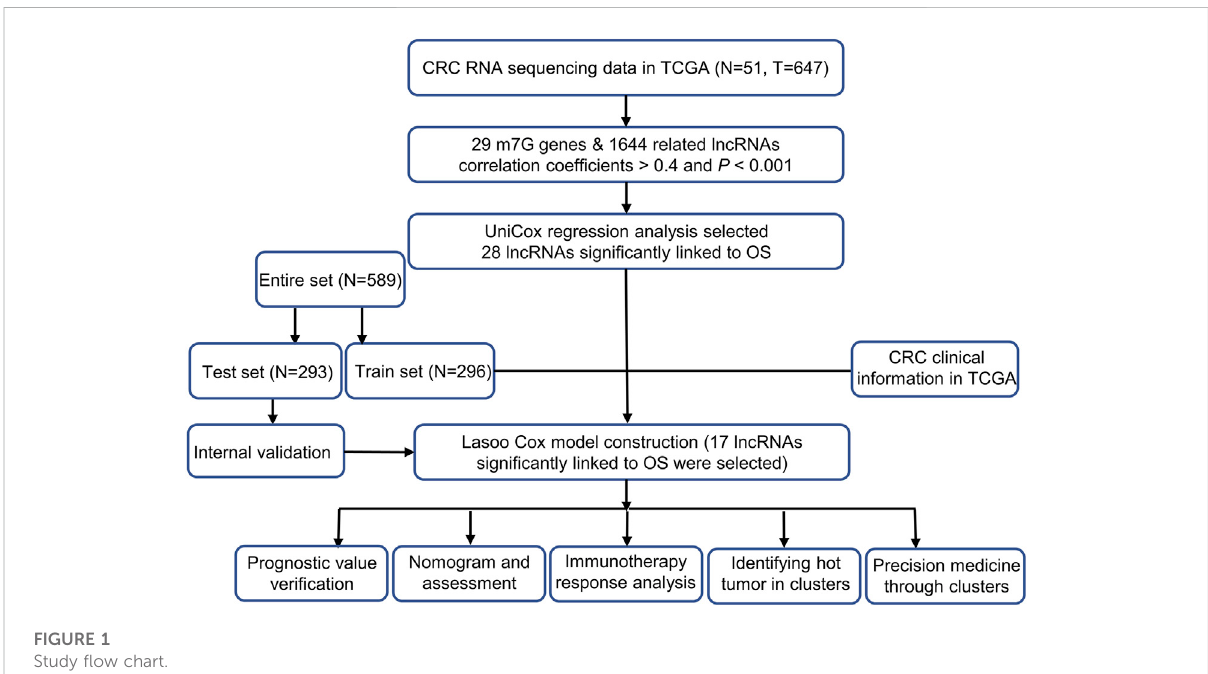
FIGURE 1 Study fl ow